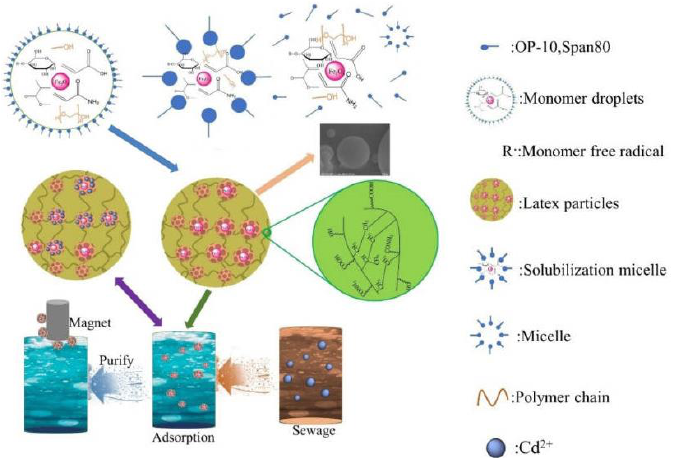
Figure 10. Schematic diagram of the AAM-MSMPM adsorption process.